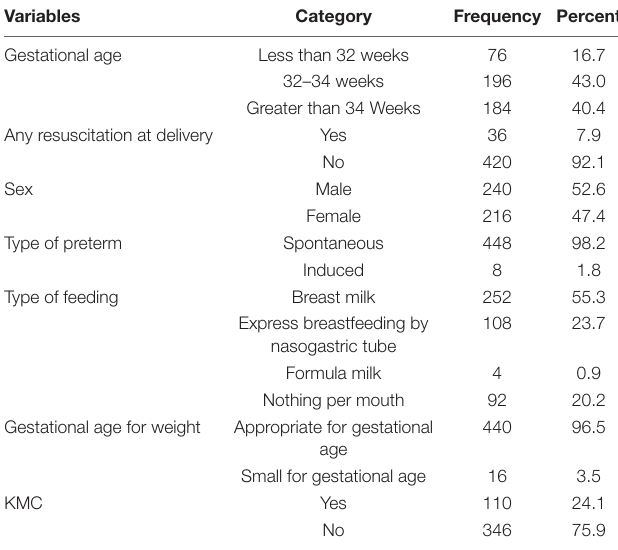
TABLE 3 | Neonatal-related characteristics among preterm neonates in south Gondar zone public hospitals, northwest Ethiopia, 2021. Variables